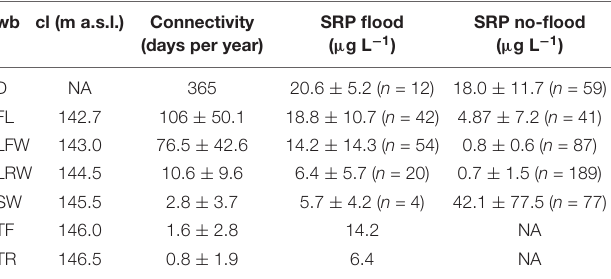
Concentrations ( ± standard deviation) are in µ g L − 1 . Concentrations of adjacent water bodies were assigned to temporary water bodies (TR, TF). Danube River (D) concentrations. Connectivity is the average number of days per year (period 1999– 2019), where the water level of the main channel exceeded the connectivity level of a water